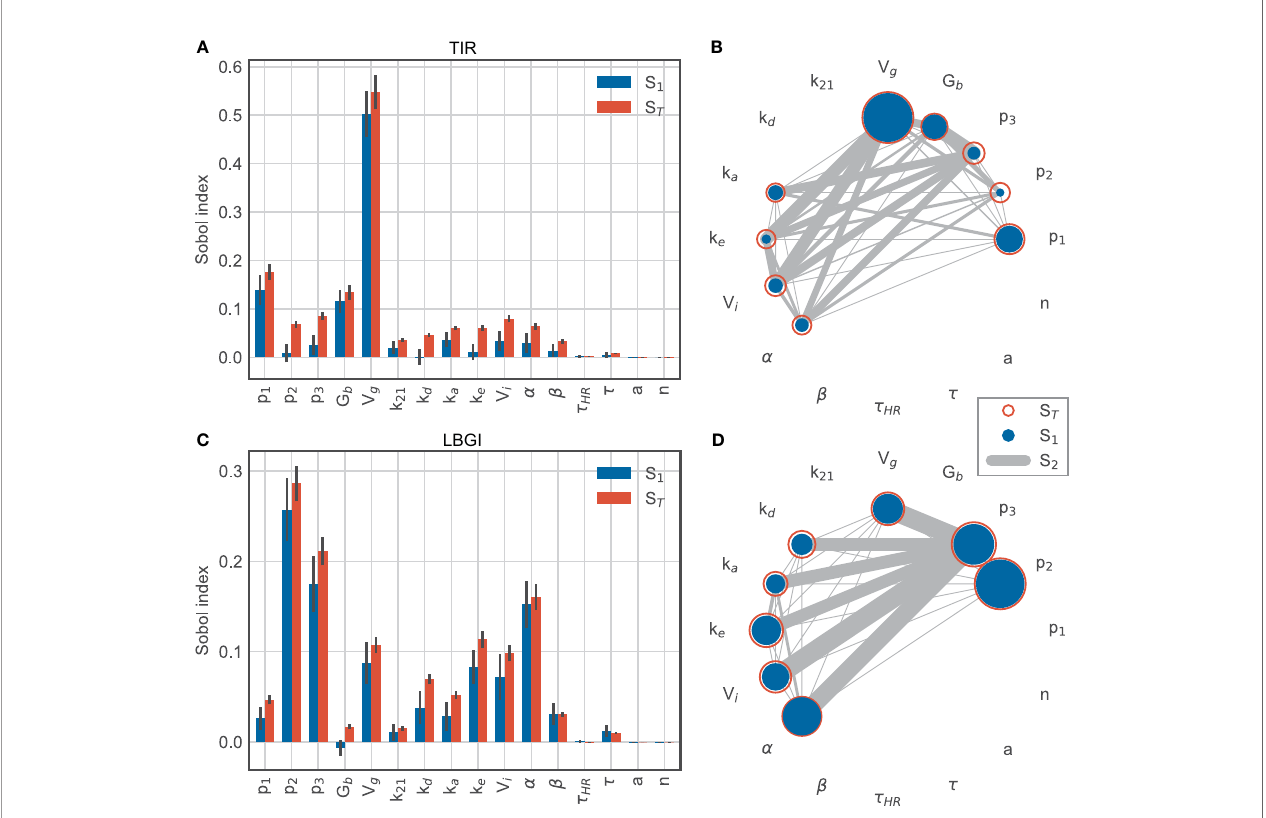
FIGURE 6 | Sobol sensitivity indices for time-in-range (top row) and low blood glucose index (bottom row). (A, C) main effect S 1 and total effect S T . (B, D) second- order effects S 2 for parameters with a minimum total effect of